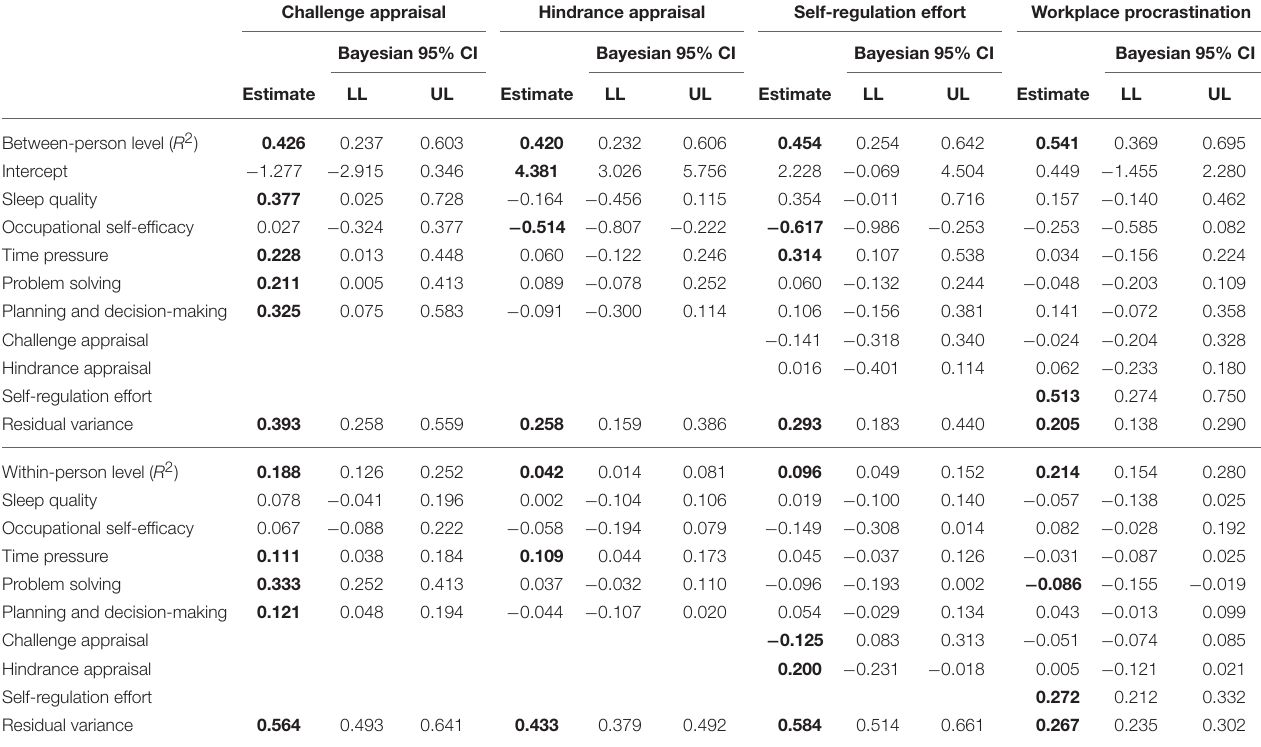
TABLE 2 | Results from Bayesian MSEM